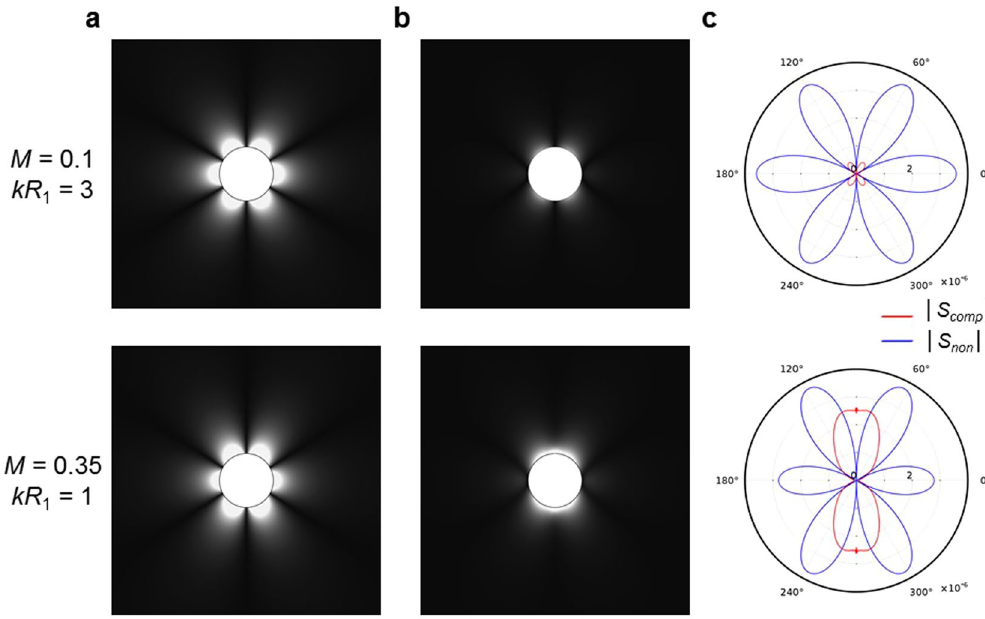
Figure 5. Comparison between compressibility and non-uniformity effects. ( a ) The magnitude of non- uniformity source terms in equation (4). ( b ) The magnitude of compressibility source terms in equation (3). ( c ) Comparison of directivity plots along the surface of the acoustic cloak ( r = R 2 ). In all figures, the Mach numbers and the Helmholtz numbers are set as kR 1 = 3 and M = 0.1 for top panel and kR 1 = 1 and M = 0.35 for bottom panel. As shown in ( a ) and ( b ), the non-uniformity term shows the hexapole pattern regardless of the Helmholtz numbers and the Mach numbers, but the polarity and magnitude of compressibility term depend on the Helmholtz number and the Mach number. As shown in ( c ), the polarity of compressibility term is changed from skewed quadrupole to dipole as the Mach number increases and the Helmholtz number